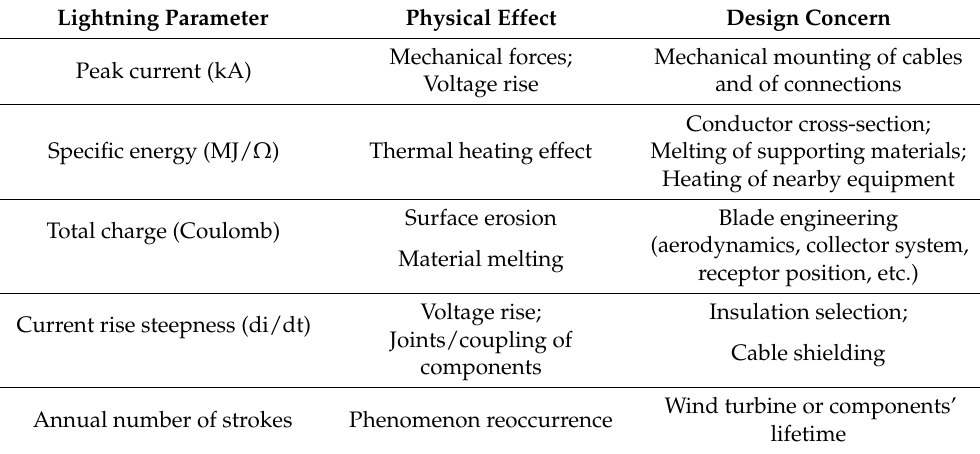
Table 1. Physical effect of the lightning parameters and design adaptations of LPS to mitigate the effects [1,4]. Lightning Parameter Physical Effect Design Concern Mechanical forces; Mechanical mounting of cables Peak current (kA) Voltage rise and of connections Conductor cross-section; Specific energy (MJ/ Ω ) Thermal heating effect Melting of supporting materials; Heating of nearby equipment Surface erosion Blade engineering Total charge (Coulomb) (aerodynamics, collector system, Material melting receptor position, etc.) Voltage rise; Insulation selection; Current rise steepness (di/dt) Joints/coupling of Cable shielding components Annual number of